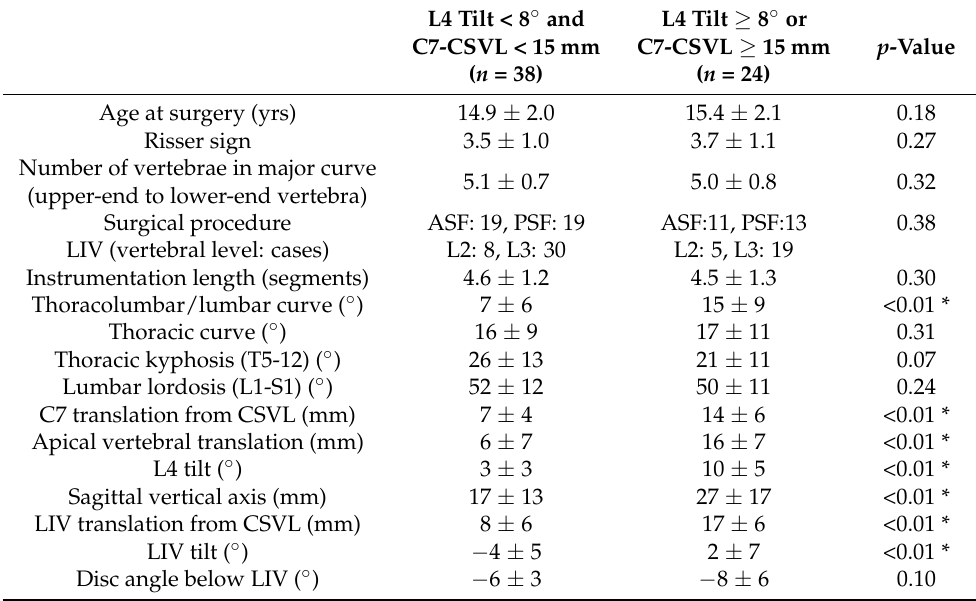
Table 5. Demographic and radiographic parameters at final